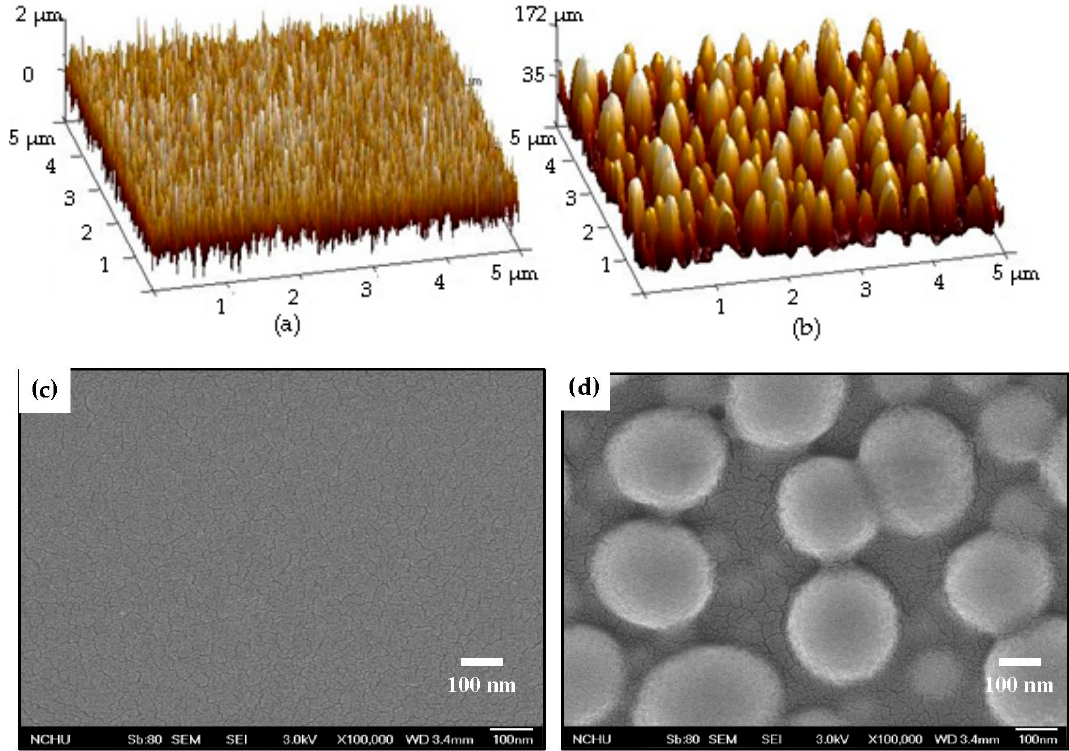
Figure 8. Surface roughness and morphologies of the CF 4 plasma etching for 40 s on the organosilicon film deposited onto: ( a , c ) the silicon substrate; and ( b , d ) the as-deposited Ag seed layer.